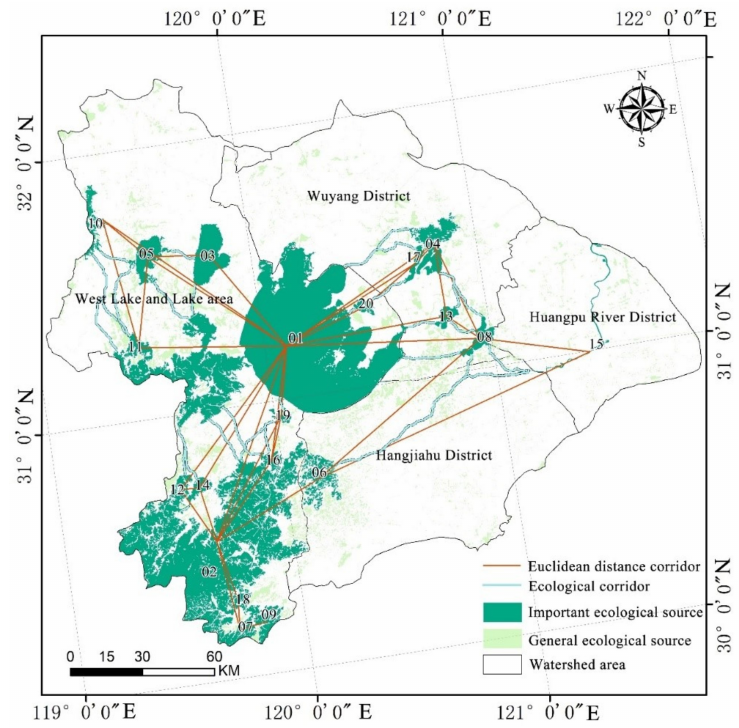
Figure 6. Ecological corridor distribution around Taihu Lake Basin.